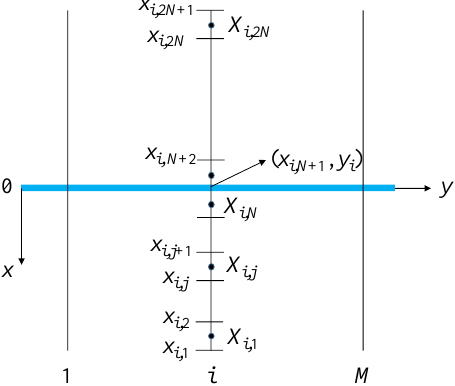
Figure 2. Physical model of a multi-stage fractured horizontal well.